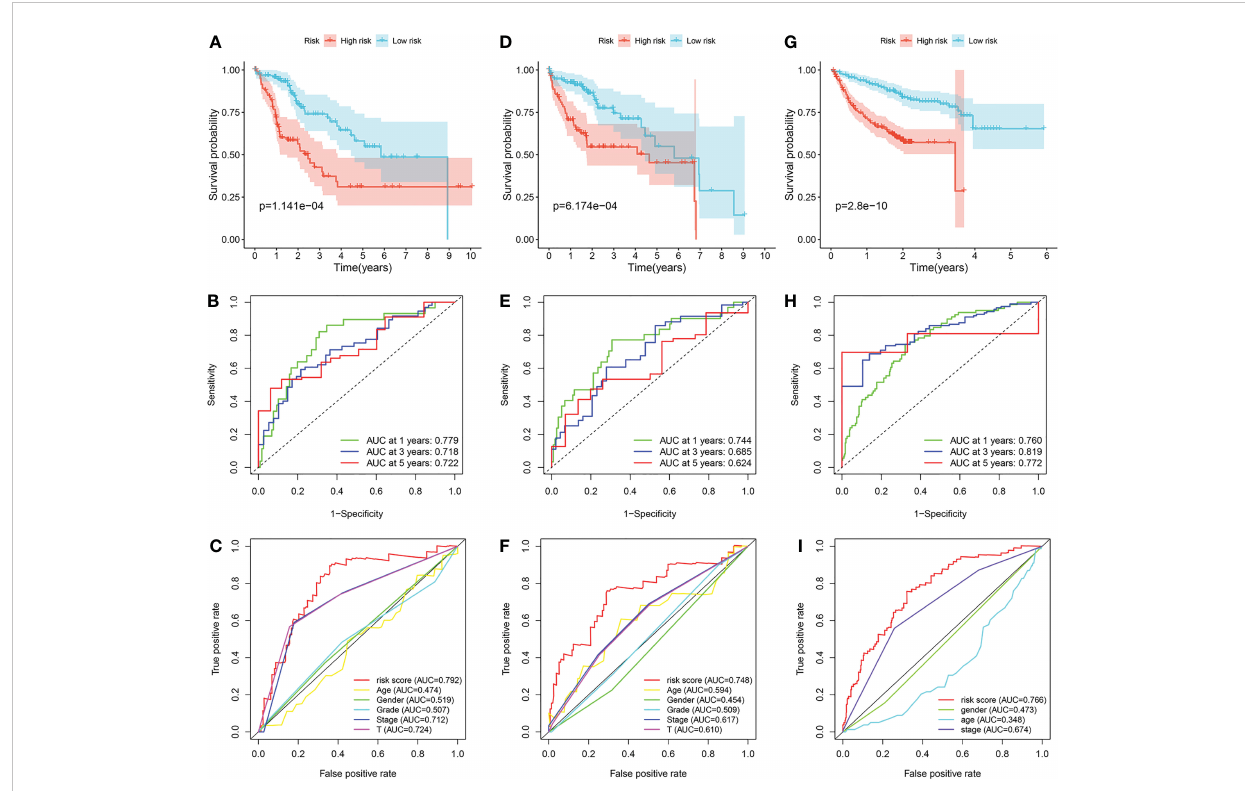
FIGURE 6 Validation of the prognostic signature. (A – C) Application of the prognostic signature in the training cohort. (D – F) Application of the prognostic signature in the internal validation cohort. (G – I) Application of the prognostic signature in the ICGC